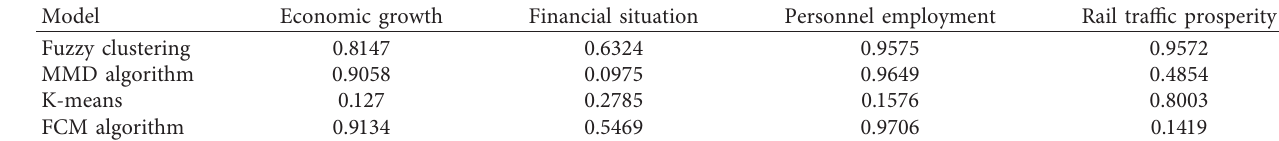
Table 3: Three indicators by different intelligent analysis methods.